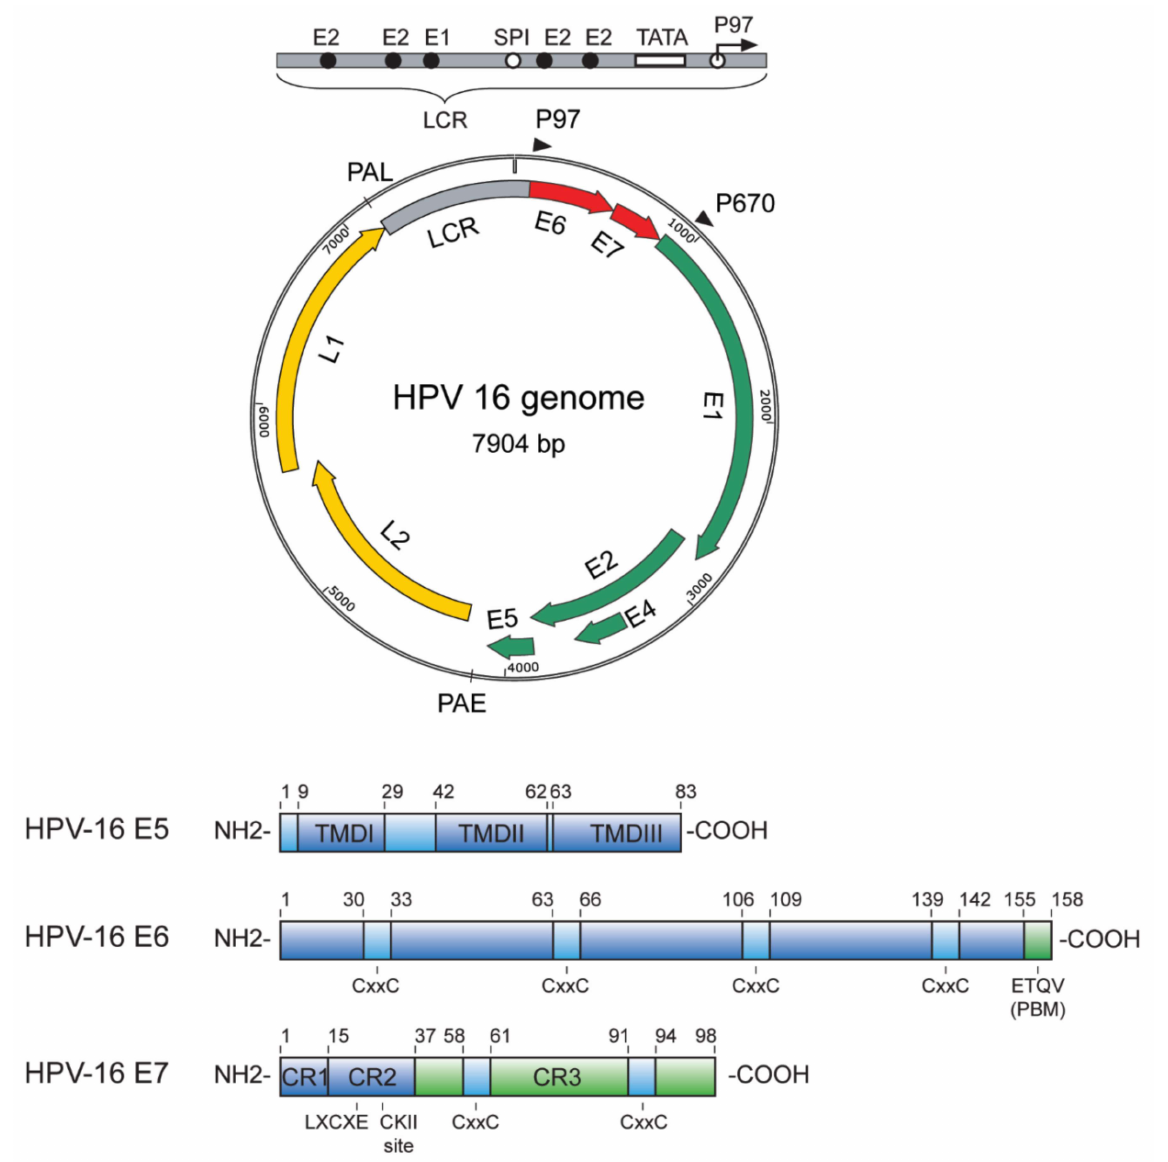
Figure 2. Schematic representation of the HPV genome